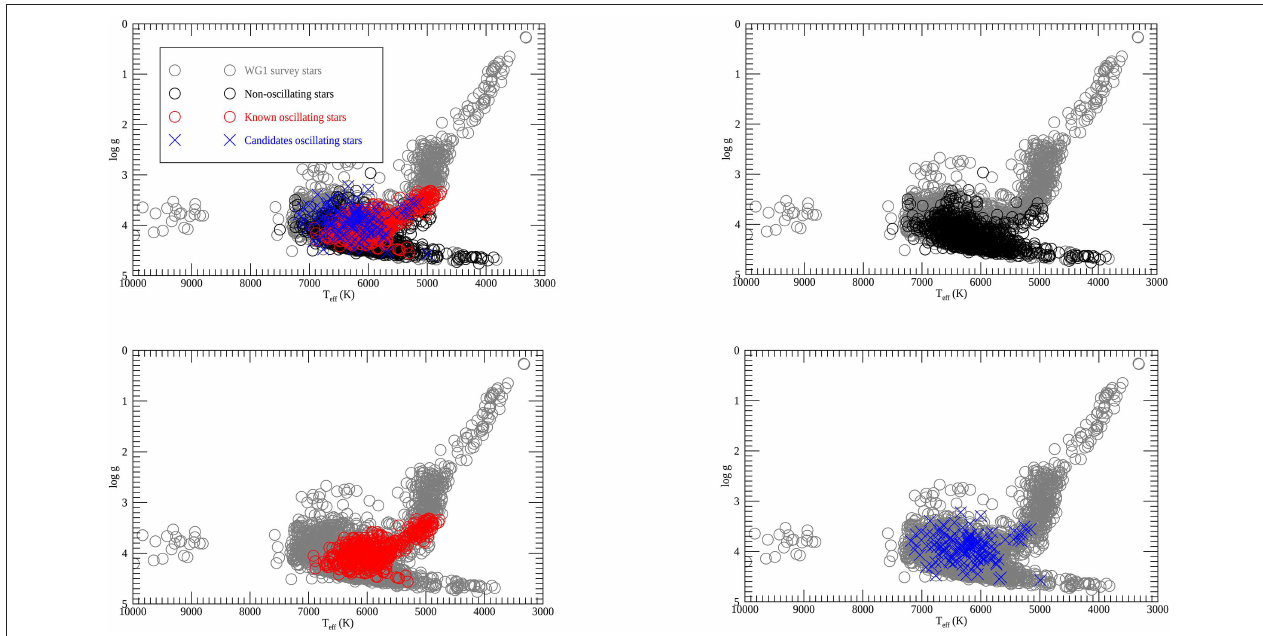
FIGURE 1 | Hertzsprung-Russel Diagram for the different samples of stars mentioned in the paper. The gray circles represent KASC WG1 stars that were observed in short cadence during the survey phase. The red circles are the main-sequence stars with known oscillations from literature. The black circles correspond to the final set of 1,014 stars obtained as described in section 2.2. The blue crosses are the new candidates with detection of